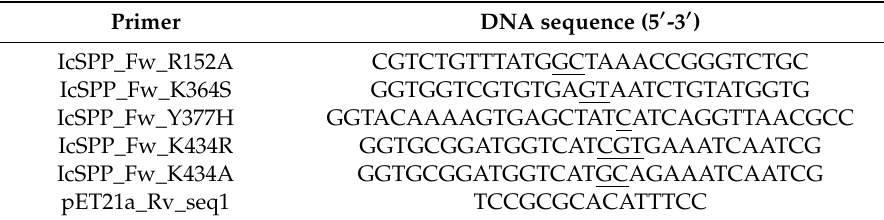
Table 3. Primers used in this study. Mutations are